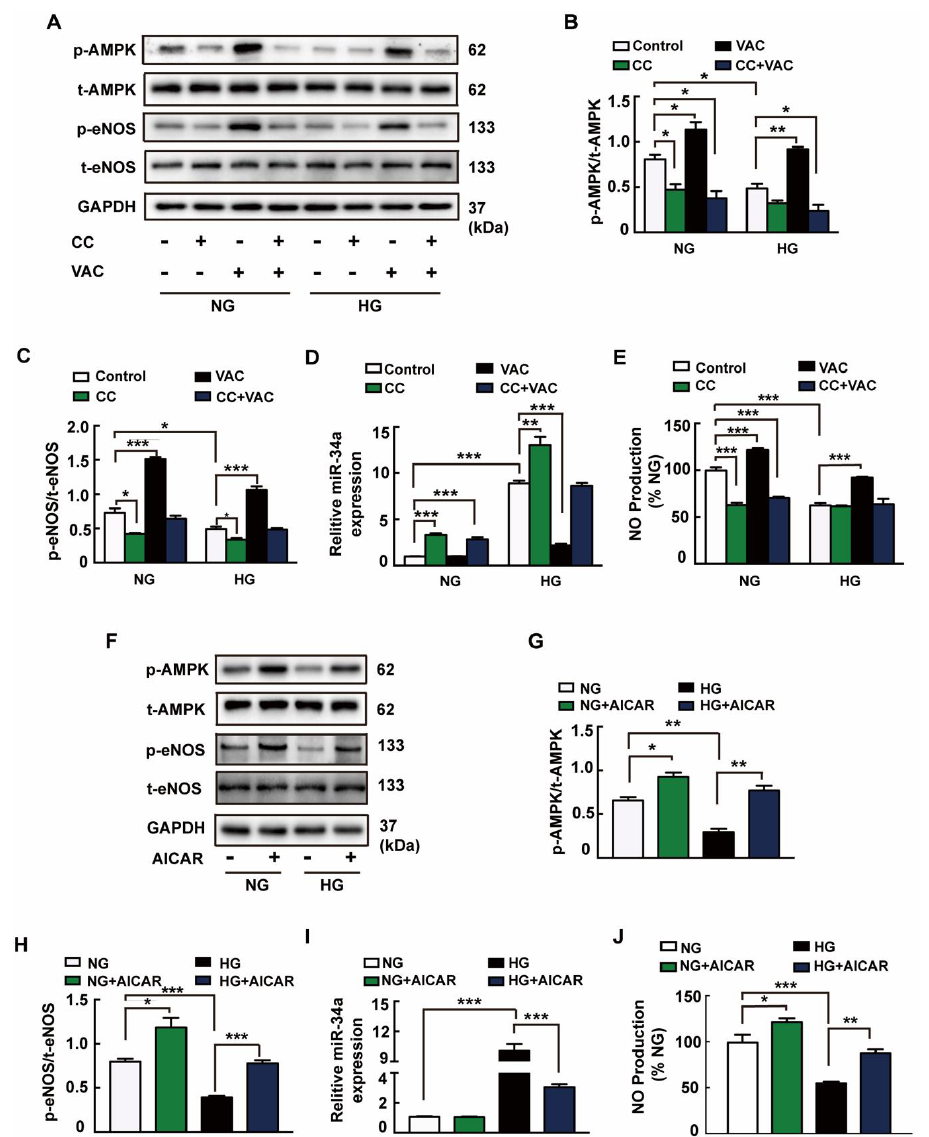
Figure 4. VAC stimulated AMPK to improve NO production and attenuate miRNA-34a expression. The HMEC-1 cells were pre-incubated with vaccarin (5 µ M) for 12 h or AMPK inhibitor CC (5 µ M) or AMPK activator AICAR (1 mM) for 1 h prior to 30 mM HG exposure. ( A ) Representative blots showing protein expression of p-AMPK and p-eNOS in HMEC-1 cells. Bar groups showing that the quantification of p-AMPK / t-AMPK ( B ) and p-eNOS / t-eNOS ( C ). E ff ects of CC (5 µ M) on the miRNA-34a expression ( D ) and NO generation ( E ) in response to HG. ( F ) Representative blots showing protein expressions of p-AMPK and p-eNOS in HMEC-1 cells. Column groups showing that the quantification of p-AMPK / t-AMPK ( G ) and p-eNOS / t-eNOS ( H ). E ff ects of AICAR (1 mM) on the miRNA-34a expression ( I ) and NO generation ( J ) in response to HG. n = 3 for each group in A–C and F–H; n = 5 for other groups. Values are mean ± SEM. * p < 0.05, ** p < 0.01, *** p < 0.001. CC, compound C; AICAR, 5-Aminoimidazole-4-carboxamide